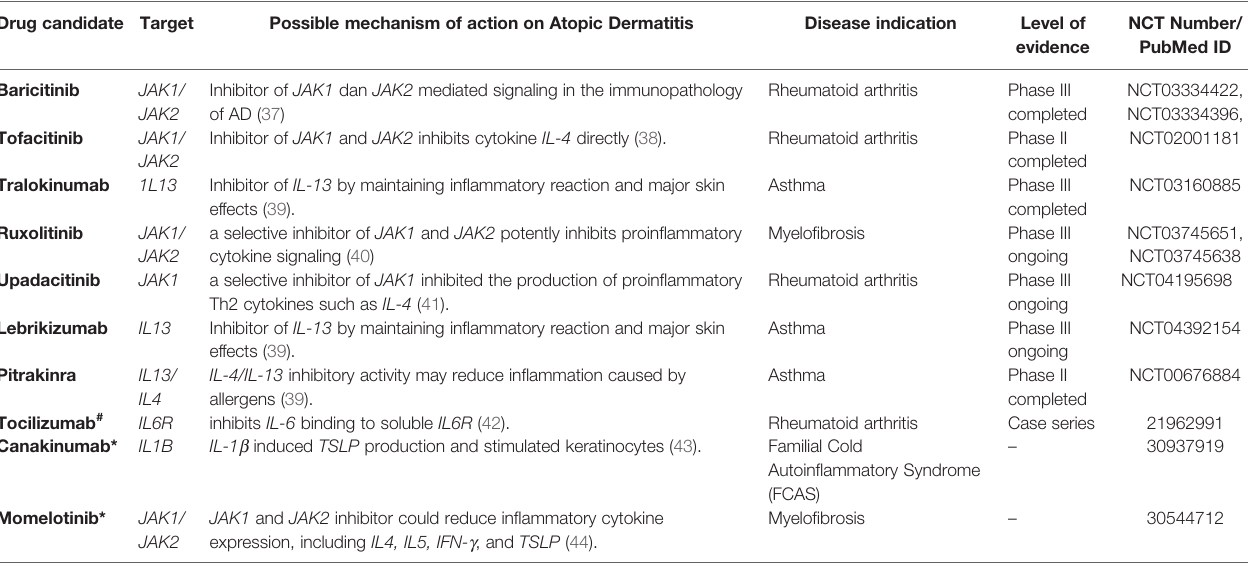
TABLE 2 | Pharmacological therapies in development for the treatment of Atopic Dermatitis. Drug candidate